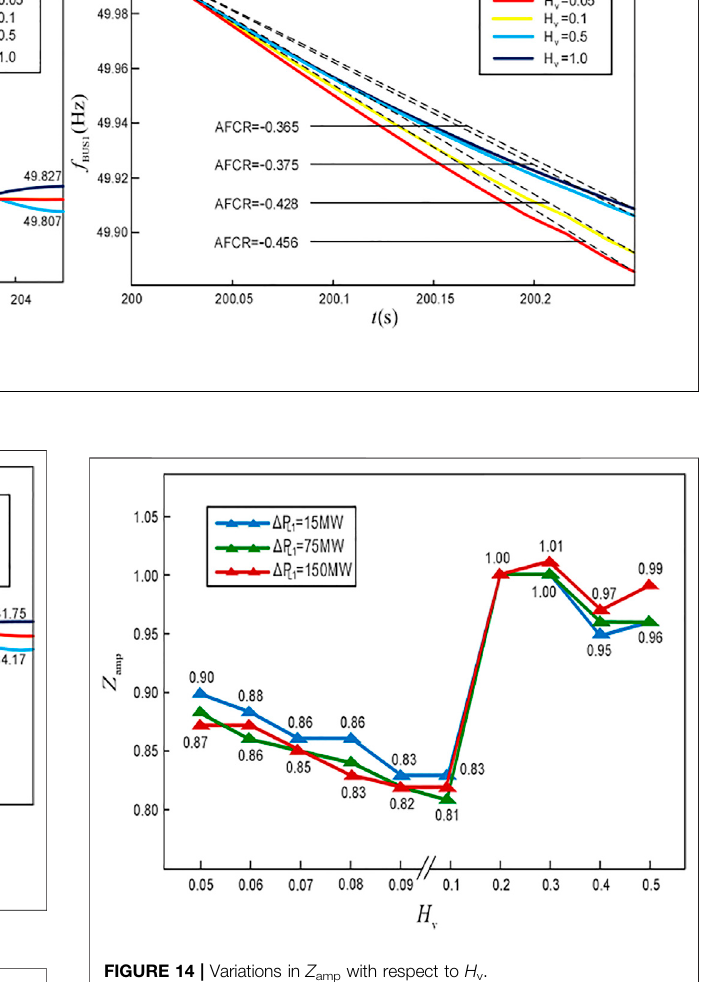
FIGURE 14 | Variations in Z amp with respect to H v